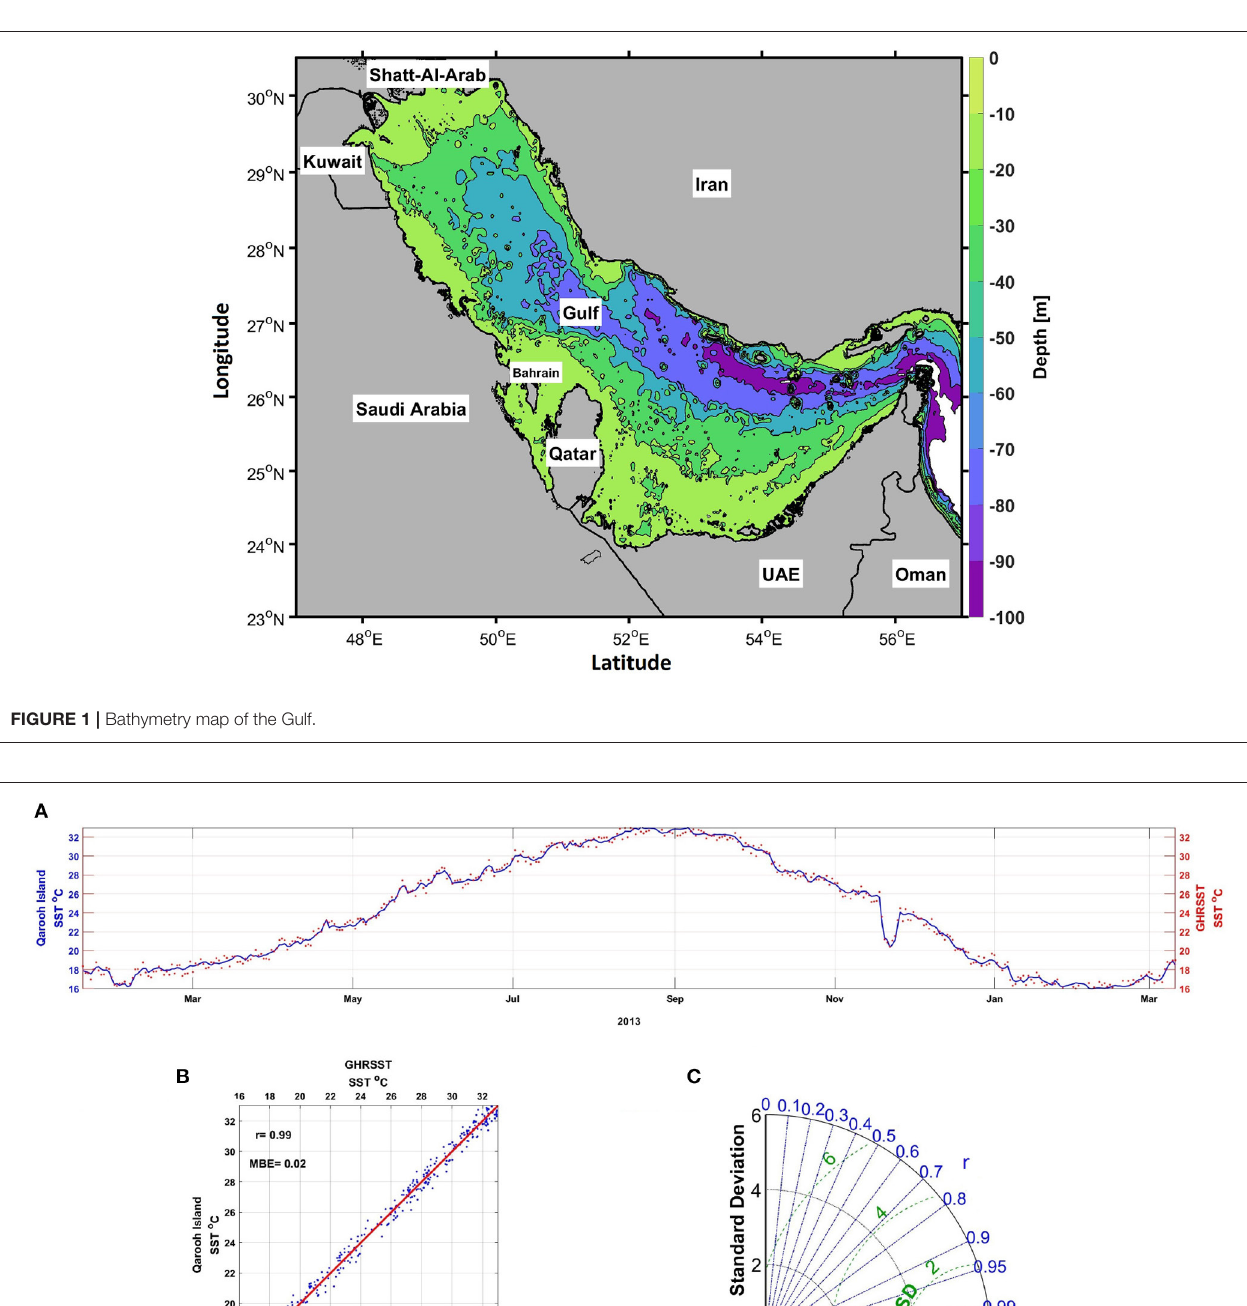
= 0.99) with the observations and displayed a Mean Bias Error (MBE) of 0.02 ◦ C ( Figures 2B,C ) capturing seasonal variability and the SST’s changes associated with various meteorological